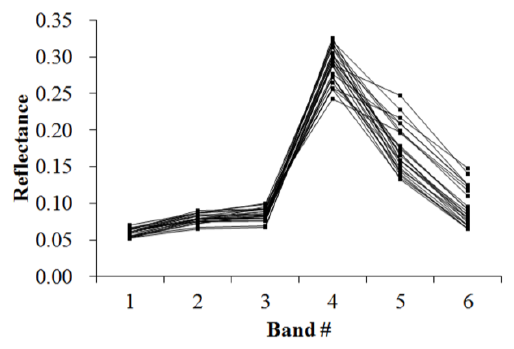
Figure 6. Spectral curves collected from samples used to determine Table 4. Table 4. Identification template 2 for cropland class.